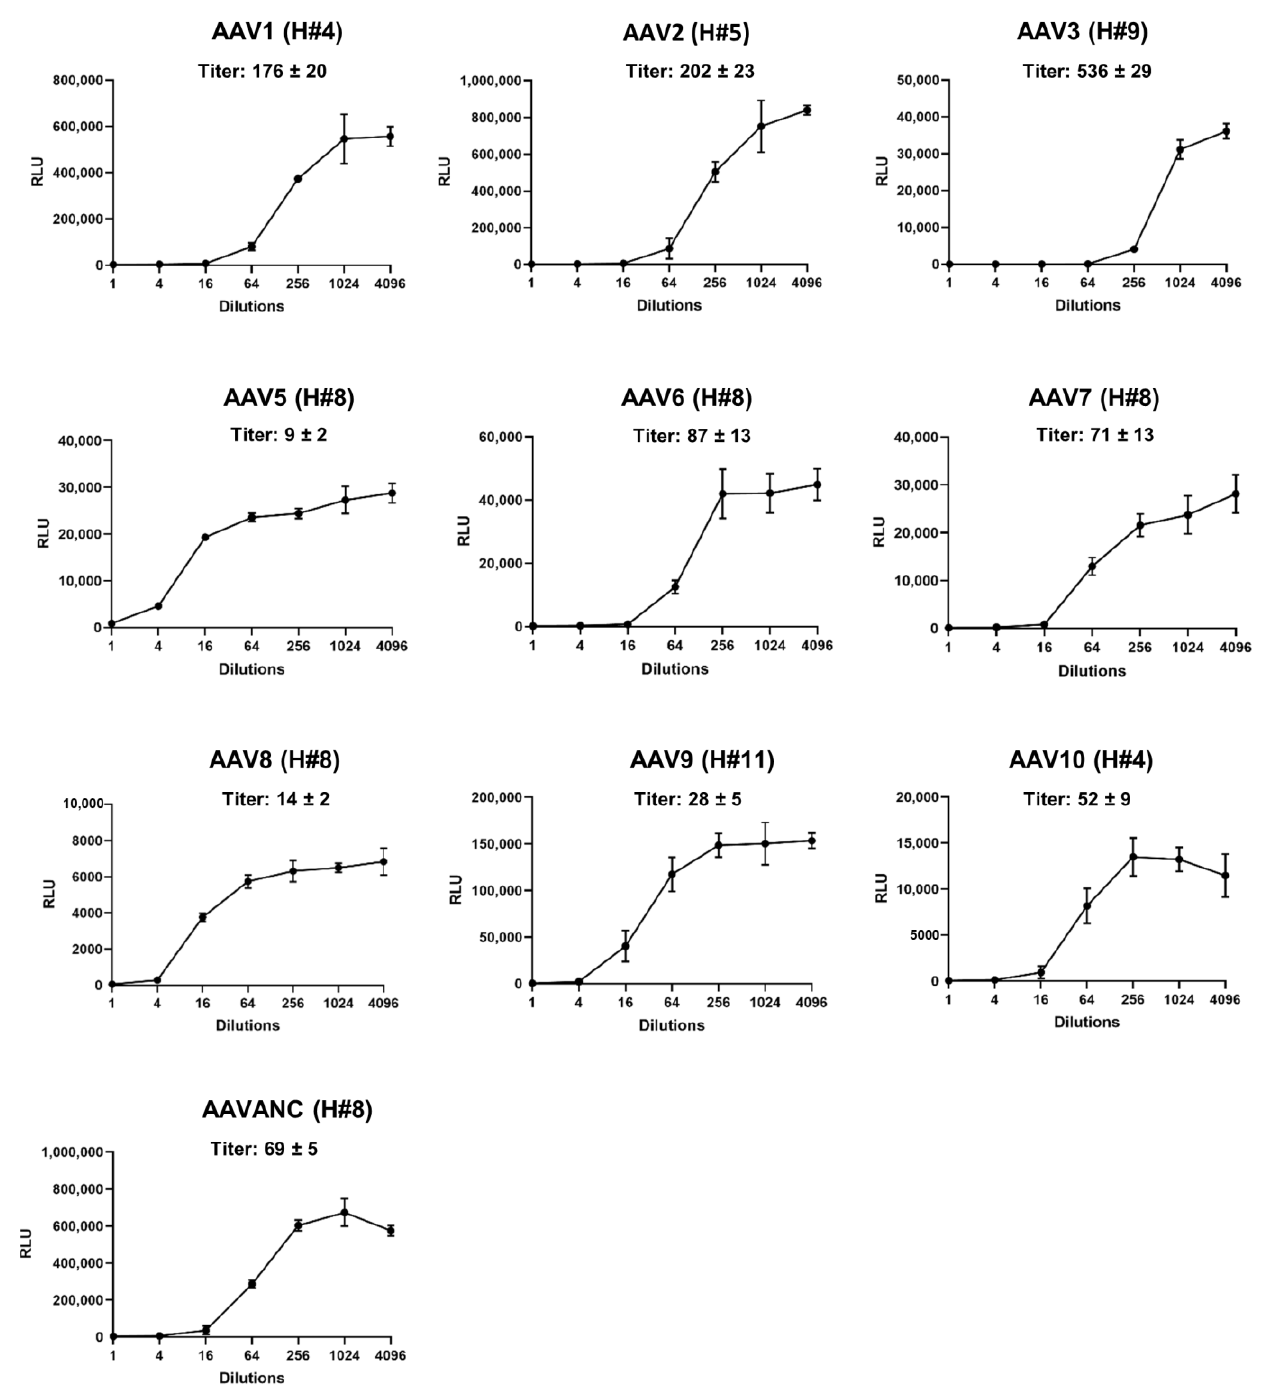
Figure 3. The determination of anti-AAV NAB titers in selected human serum samples. Human samples with titers higher than 1:32 against particular AAV serotypes were re-evaluated at dilutions ranging from 1:2 to 1:4096, and inhibitory curves were built to determine the titers. Since the NAB titers for AAV5 and AAV8 in all tested human samples were lower than 1:32, an assay was performed for several random samples as a proof of concept. The Y-axis presents chemiluminescence intensity units of the reporter luciferase encoded by AAV. NAB titers were determined as a dilution of the serum sample at which 50% of the fluorescence signal was obstructed. The representative inhibitory curve for each analyzed AAV serotype is shown.